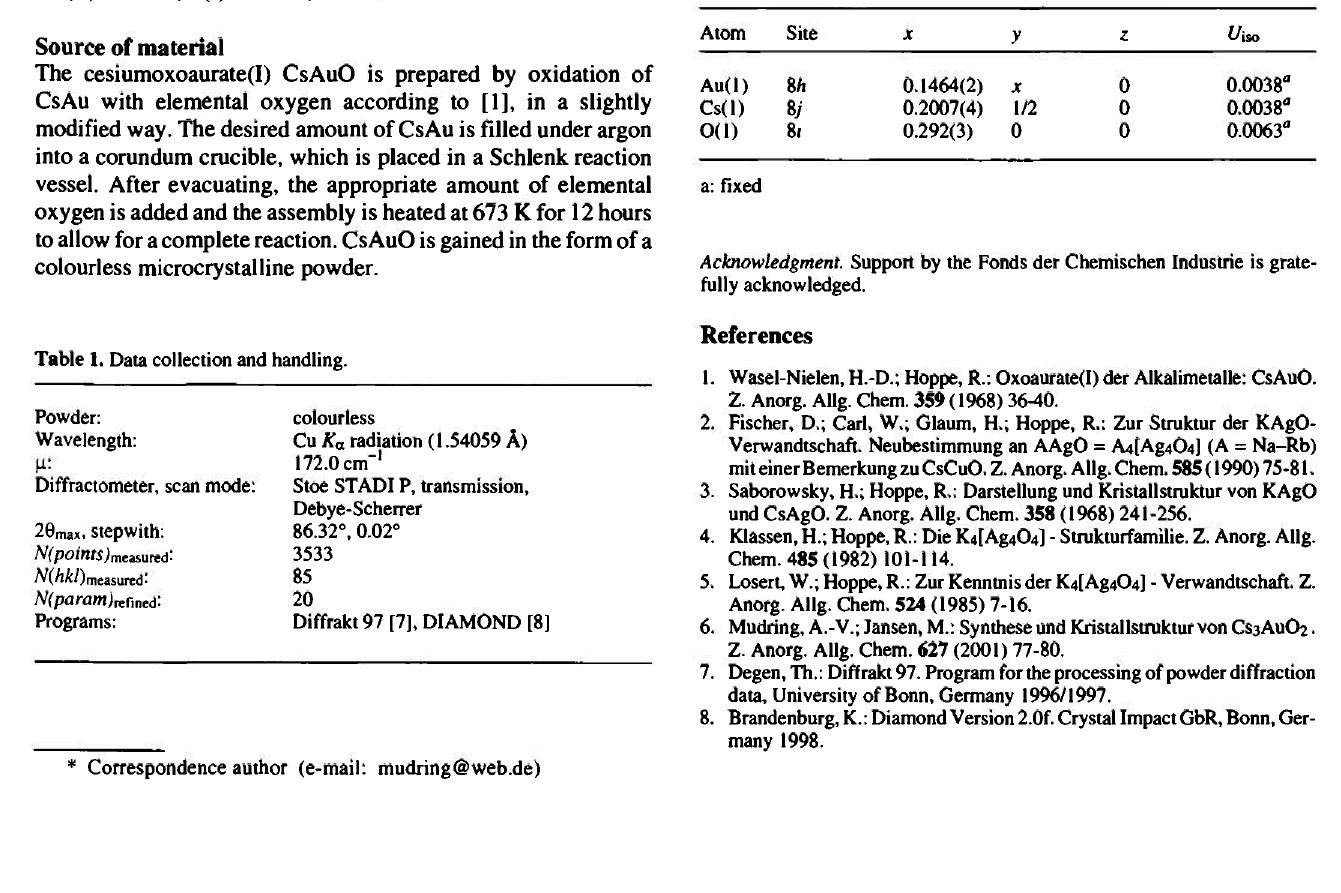
Table 2. Atomic coordinates and displacement parameters (in A 2